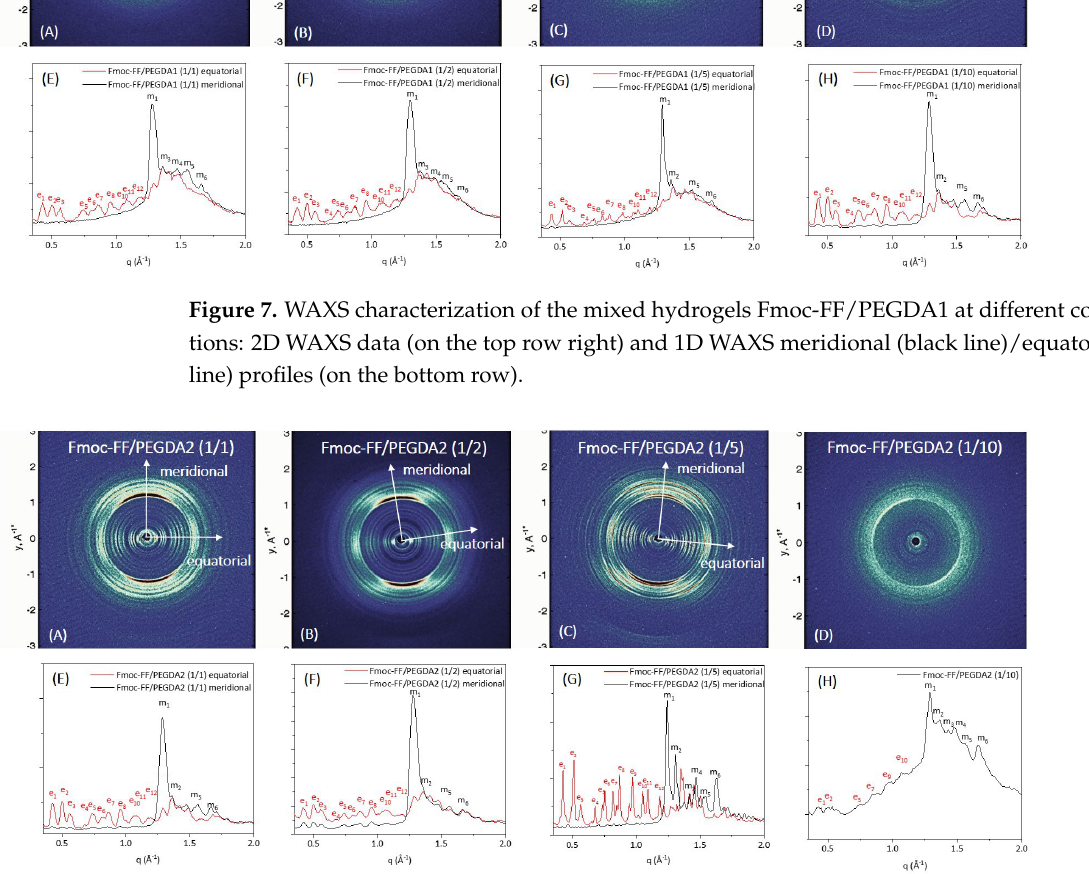
Figure 7. WAXS characterization of the mixed hydrogels Fmoc-FF/PEGDA1 at different concentra- tions: 2D WAXS data (on the top row right) and 1D WAXS meridional (black line)/equatorial (red line) profiles (on the bottom row).